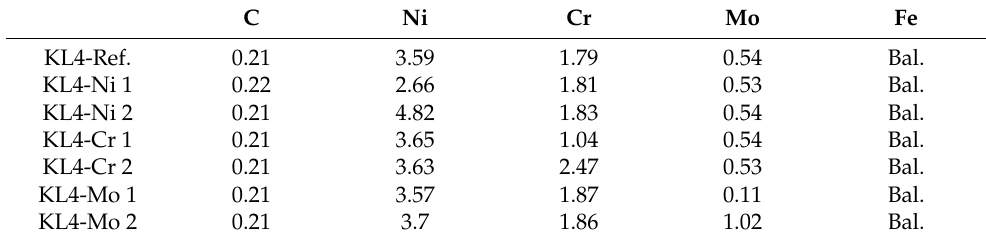
Table 5. Chemical composition of steel (wt.%) [51].